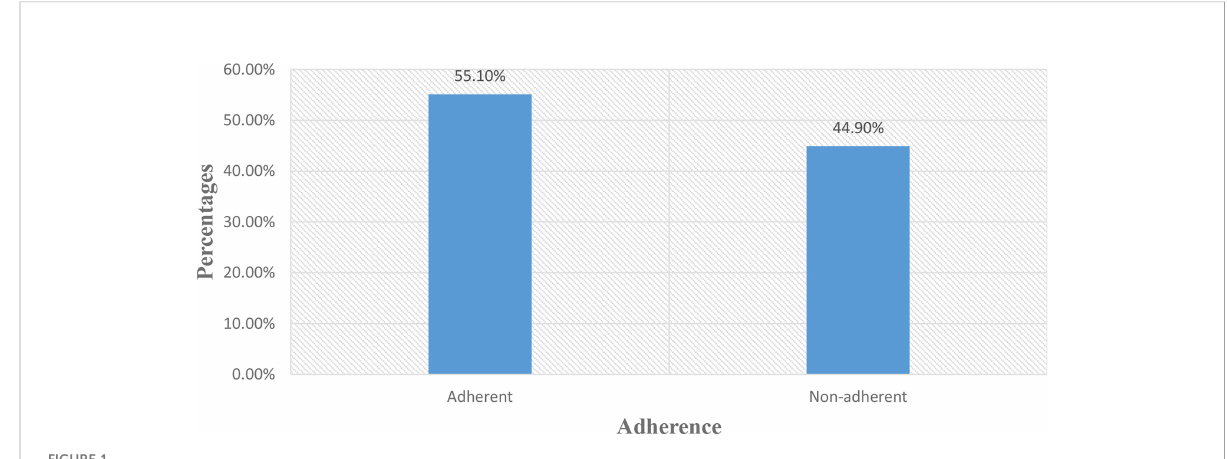
FIGURE 1 Adherence to prescribed medication among DM patients attending at Felege Hiwot Comprehensive Specialized Hospital.